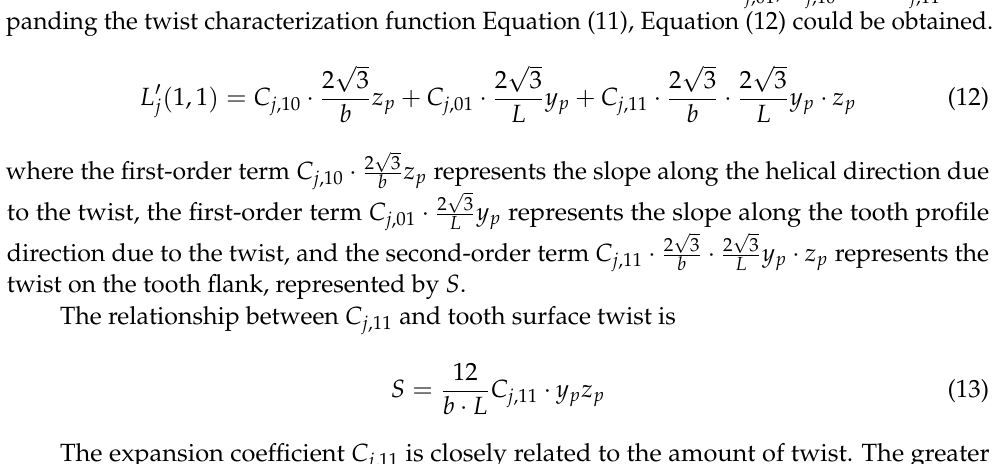
Figure 4. The tooth flank twist in the gear coordinate system and the meshing plane coordinate system. ( a ) Flank twist. ( b ) Flank twist in the meshing plane.